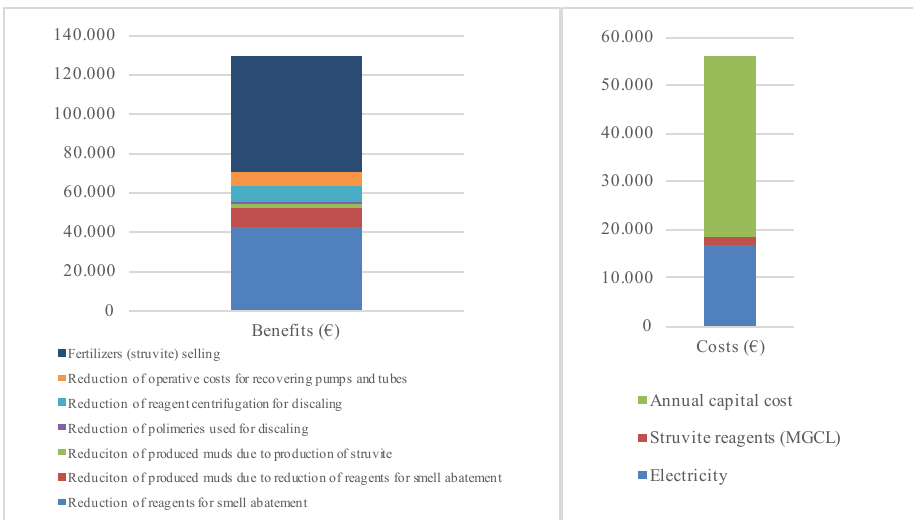
Figure 4. Costs and benefits of the use of a SCM in a 120,000 IE